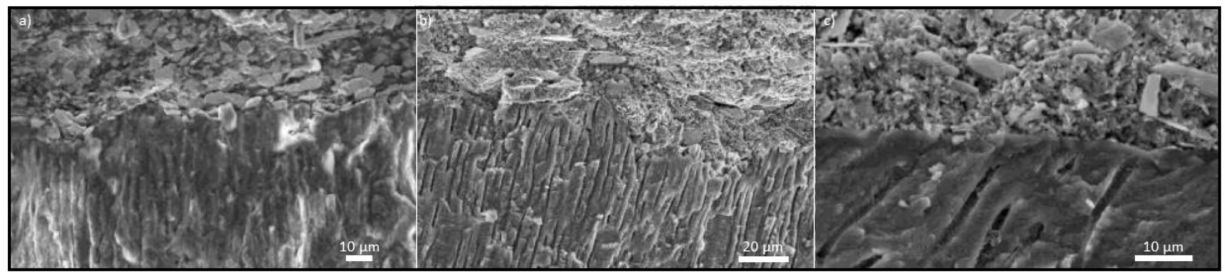
Figure 24. Close connection of the sealant with the root canal dentine with visible adhesion of thsealant to the dentin tubules after obturation with resilon as a filling material by thermoplastic condensation using the THC technique (SEM): ( a – c ) even distribution of the sealant, which borders on the root canal dentin, closing the mouths of the dentinal tubules and covers resilon as filling material.